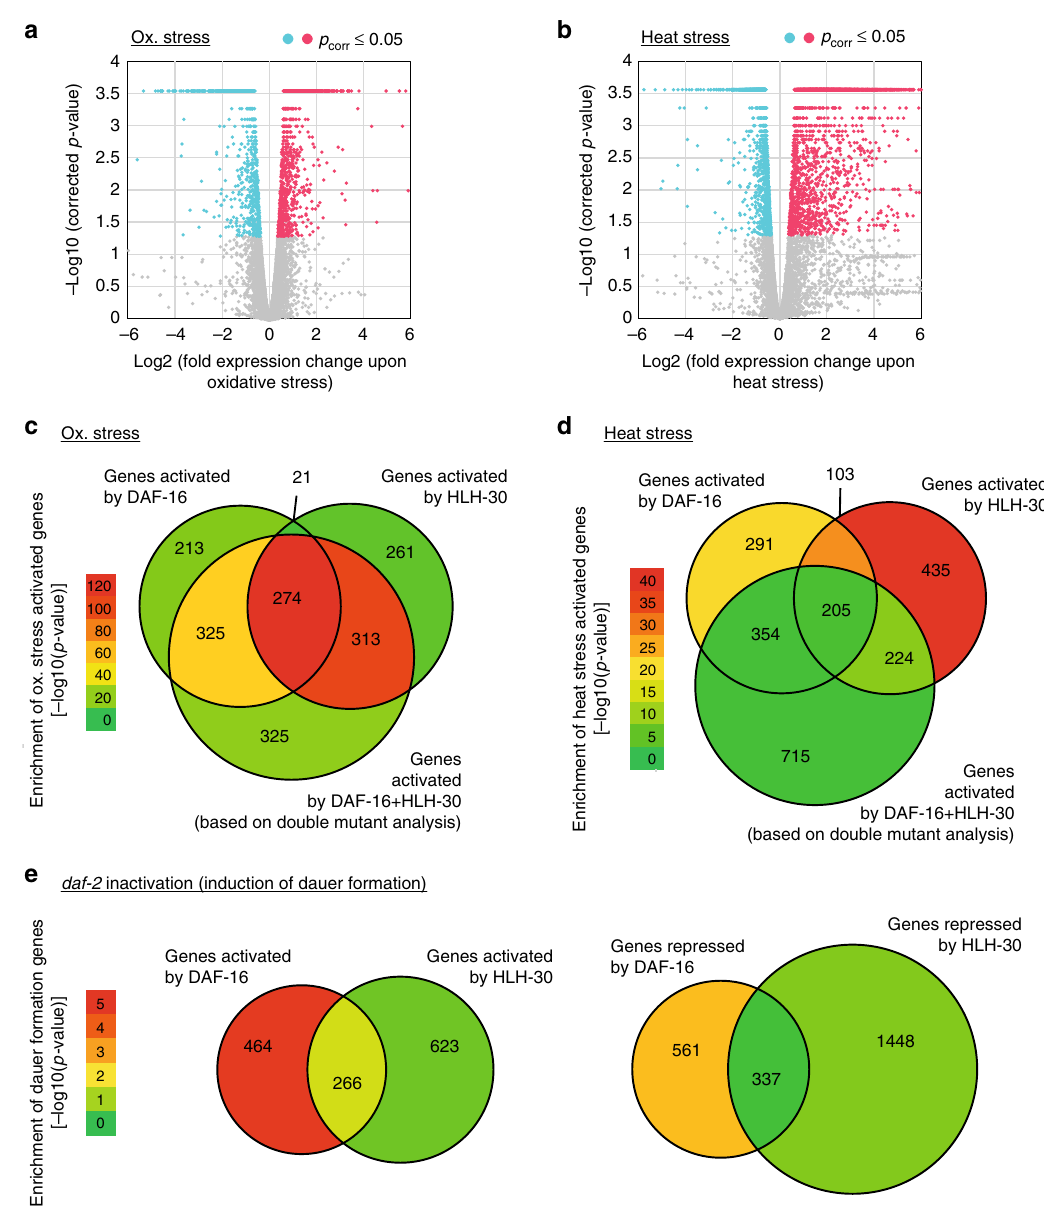
Fig. 7 The context-dependent genetic interactions between daf-16 and hlh-30 can be explained by the distinct distribution of the different response genes between genes individually or co-regulated by these transcription factors. a , b Genes differentially expressed upon oxidative stress or heat stress. Wild type animals were grown at 20 °C until young adulthood, then transferred for 12 h to either 6 mM tBOOH (oxidative stress) ( a ) or to 32 °C (heat stress) ( b ), harvested, and their transcriptomes determined by mRNA-seq. The volcano plots illustrate the fold expression changes and their signi fi cance for each gene of the transcriptome ( n = 20,389). c , d C. elegans with the genotypes wild type, daf-16(mu86lf) , hlh-30(tm1978lf) , and daf-16(mu86lf) ; hlh-30(tm1978lf) were grown at 20 °C until young adulthood, then transferred for 12 h to either 6 mM tBOOH (oxidative stress) ( c ) or to 32 °C (heat stress) ( d ), harvested, and their transcriptomes determined by mRNA-seq. The Venn diagrams illustrate the number of genes signi fi cantly activated by DAF-16 and/or HLH-30, based on the comparison of their mutants to wild type animals (for Venn diagrams of the repressed genes see Supplementary Fig. 6). False coloring illustrates enrichment for genes responding to oxidative stress ( c ) or heat stress ( d ), as they were determined in panels a and b , respectively. e The same Venn diagrams as in Fig. 4d, but now with false coloring illustrating the enrichment of dauer formation-related genes ( n = 276, based on GO-term and phenotypic annotations in wormbase.org). (Signi fi cance of gene expression changes in a – e was determined by Cuffdiff, using an FDR of